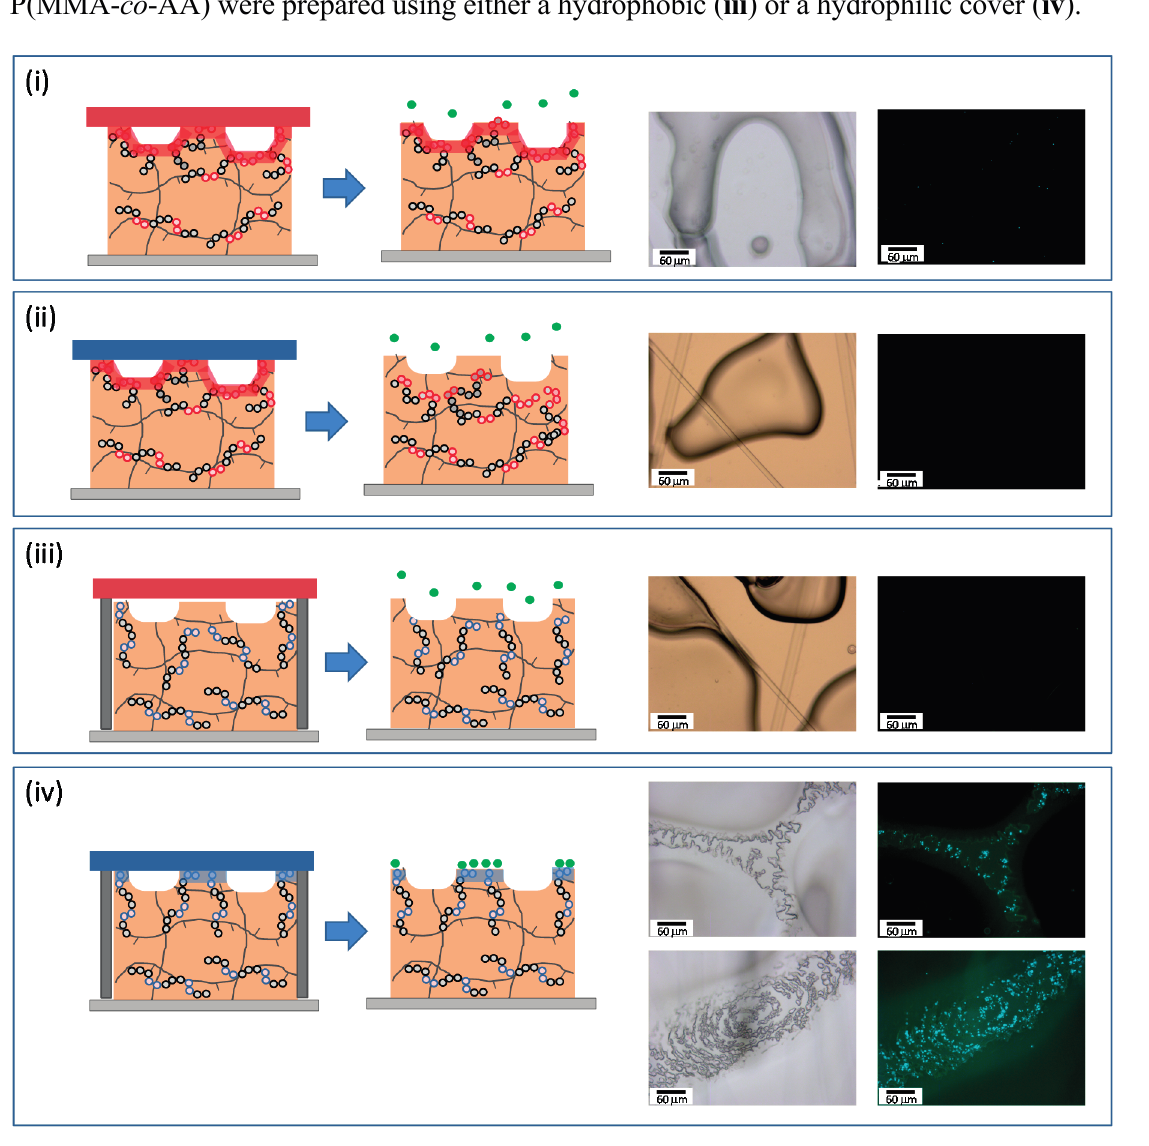
Figure 6. Immobilization of S. aureus onto wrinkled surfaces with the copolymers either P(MMA- co -TFMA) ( i and ii ) or P(MMA- co -AA) ( ii and iv ). Wrinkled surfaces